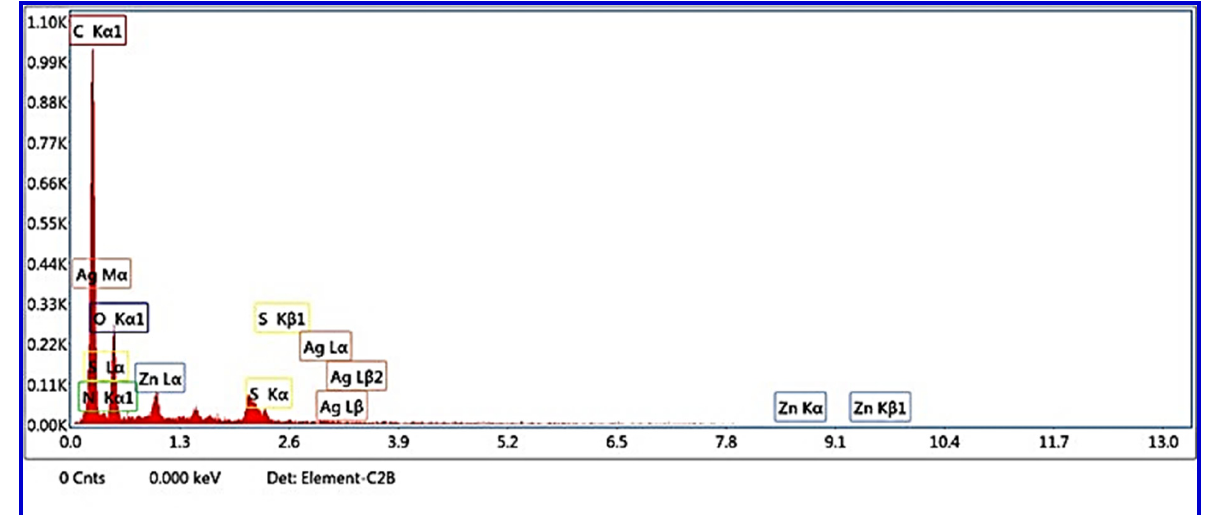
Figure 4. Energy-dispersive X-ray (EDX) spectrum of Ag 2 O/ZnS/GO/CA. Table 2. The quantification analysis of EDX is based on SEM micrographs.